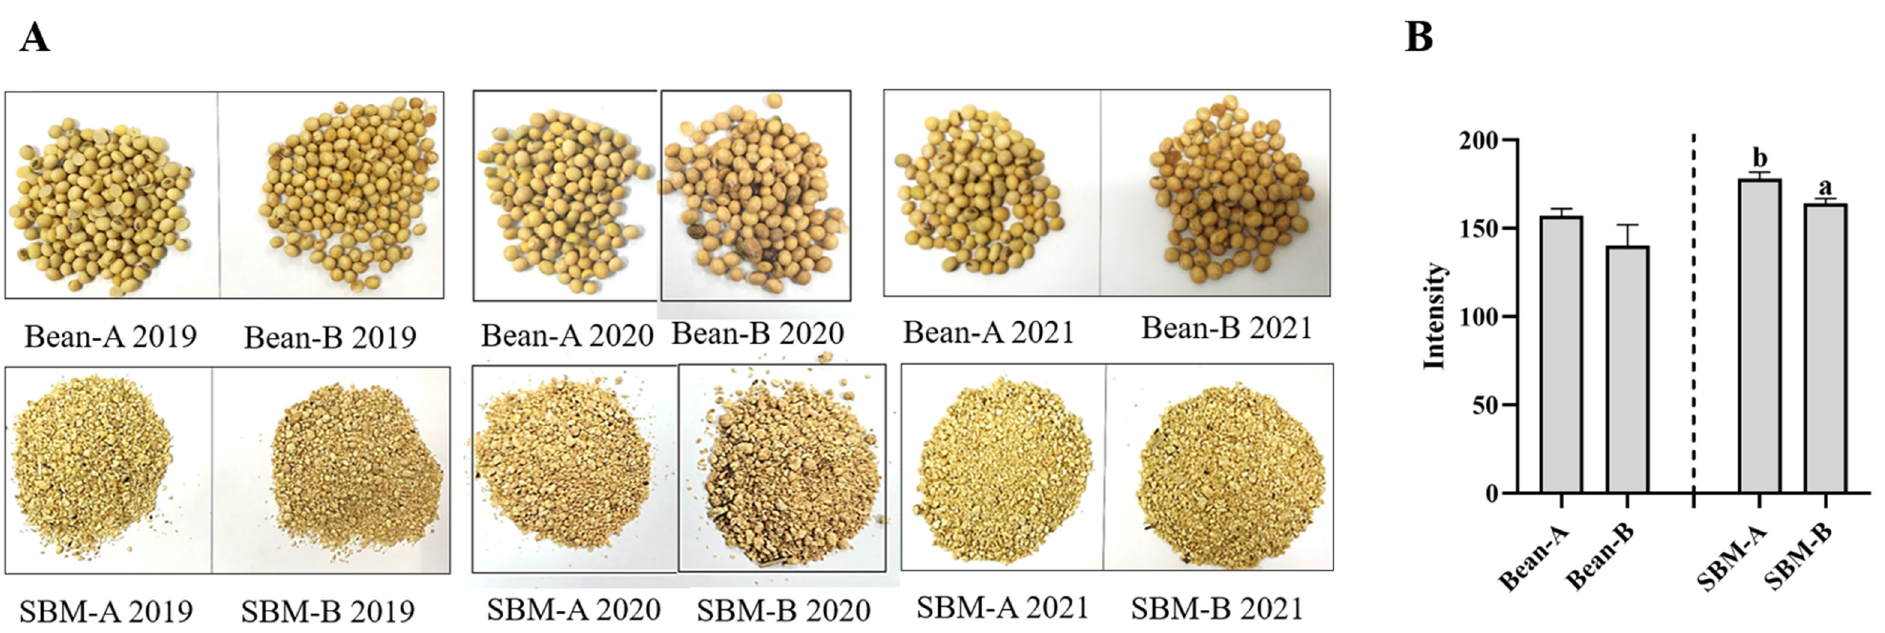
Figure 1. ( A ) The appearance of Bean-A and Bean-B in 2019–2021, and their corresponding soybean meals (SBMs); ( B ) the color intensity of tested soybeans and SBMs. Values marked with “a and b” are significantly different, ( t -test; p < 0.05), means ± SEM (standard error of treatment mean).